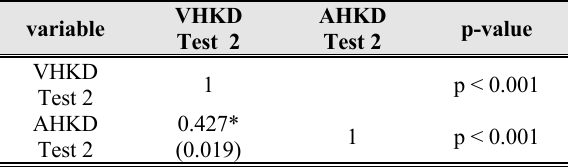
Correlation between VHKD and AHKD (Test 2)